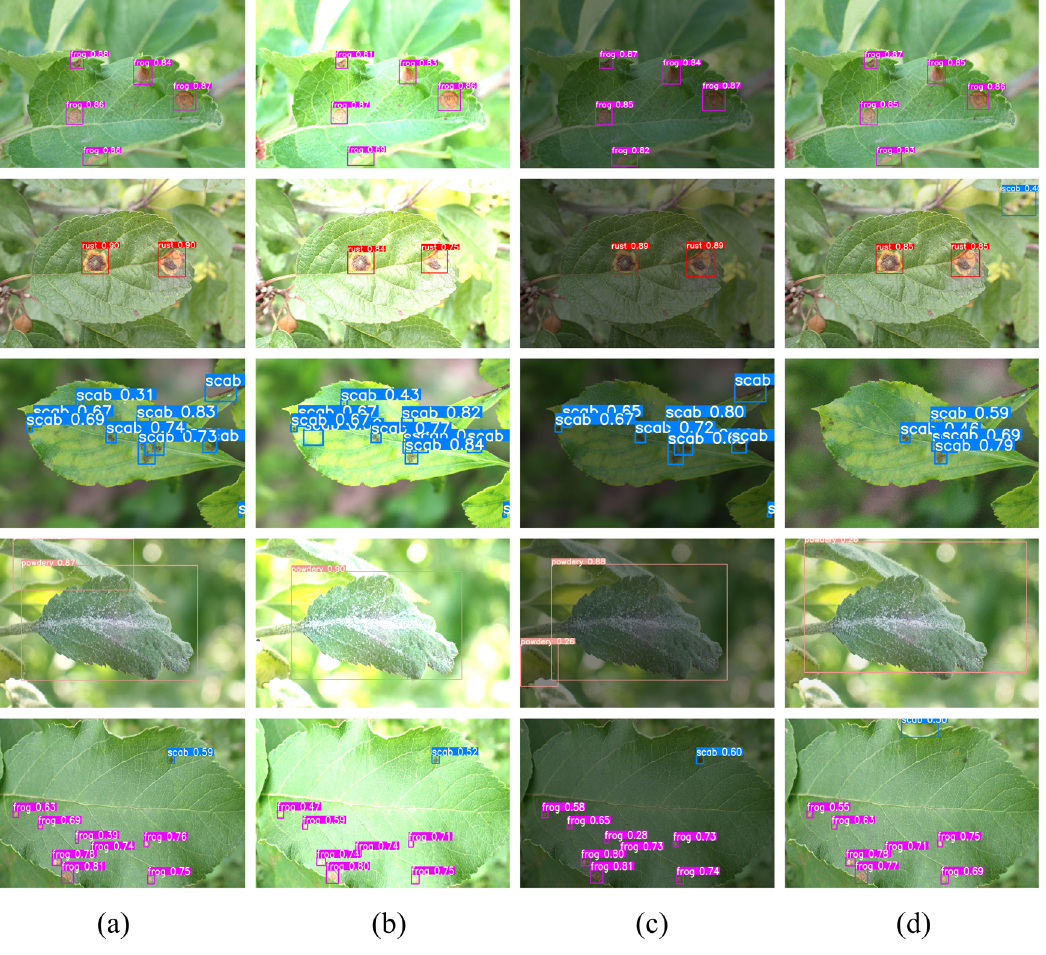
Figure 12. Robustness test results under three extreme conditions. ( a ) Original; ( b ) Bright light; ( c ) Dim light; ( d ) Blurry. Where first to fifth rows show results for apple frogeye leaf spot, rust, scab, powdery mildew, and multiple diseases, respectively.